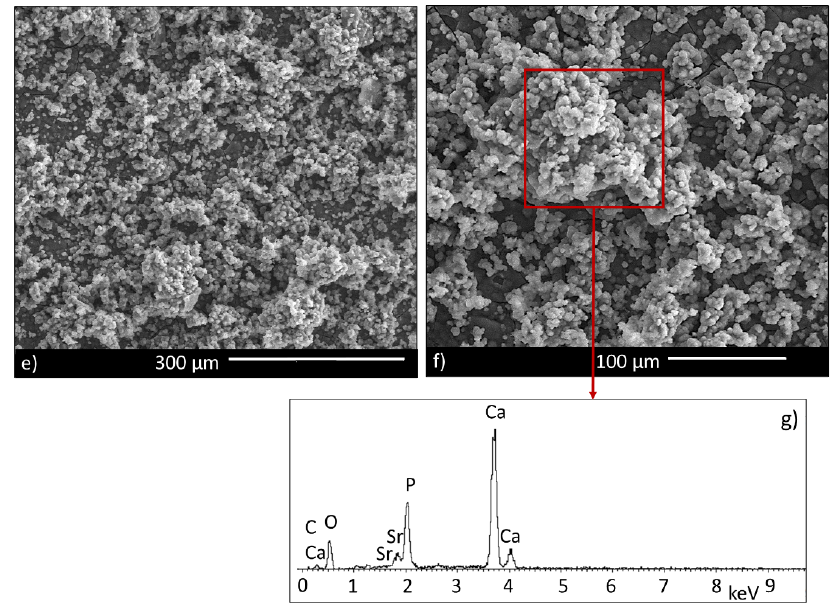
Figure 5. Hydroxycarbonate apatite formation on samples’ surfaces after 1 day ( a , b ), 7 days ( c , d ) and 14 days ( e , f ) and EDS spectrum ( g ) after immersion in simulated body fluid (SBF) solution.